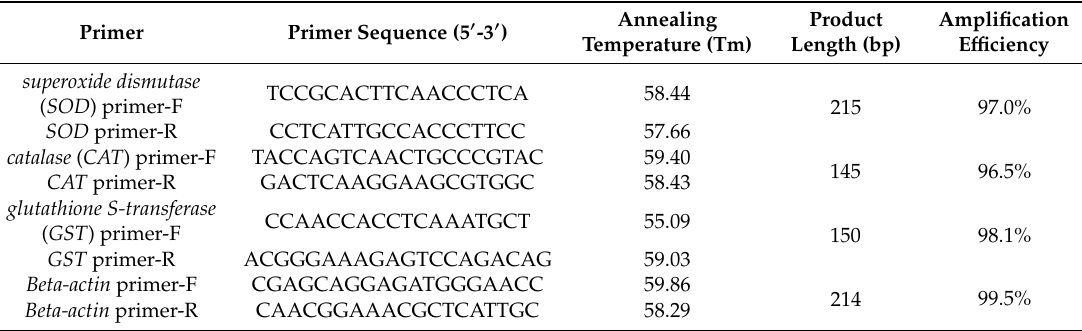
Table 1. Primer sequences used for real-time-polymerase chain reaction (PCR). Primer Primer Sequence (5 (cid:48) -3 (cid:48)